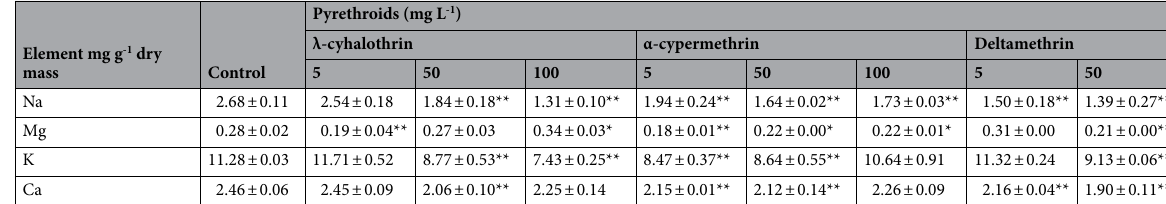
Table 2. Content of sodium, magnesium, potassium, and calcium in the B. bassiana cells after cultivation with λ-cyhalothrin, α-cypermethrin, and deltamethrin. Data are means ± SD; all samples were prepared in triplicate, and the experiments were repeated twice. Results were tested by one-way ANOVA; significance: ** P < 0.01, * P < 0.05.